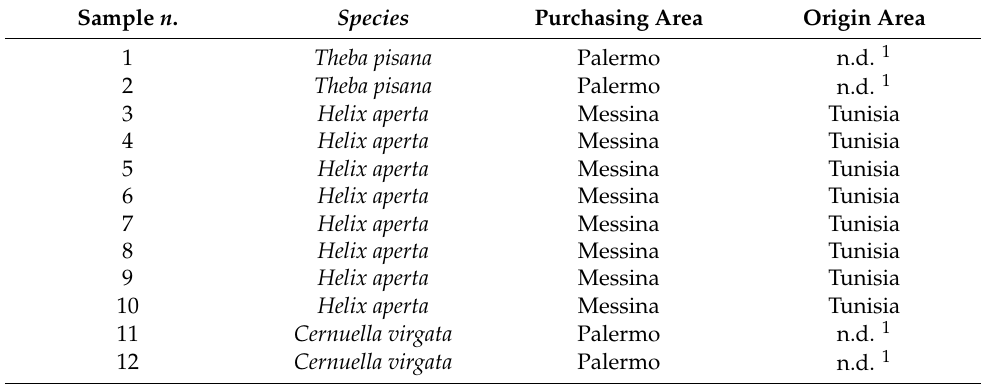
Table 1. Samples investigated and related purchasing and origin areas. Sample n